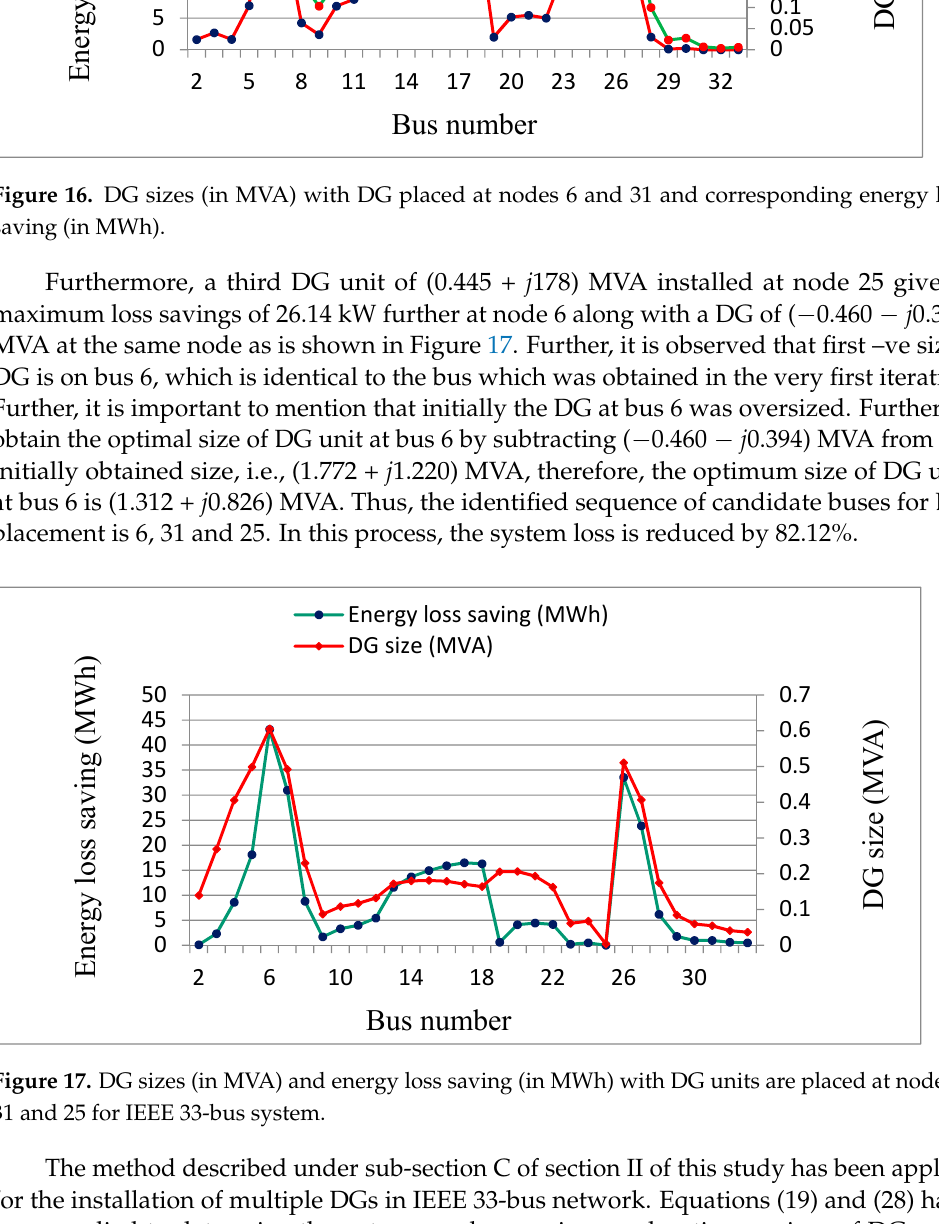
Figure 16. DG sizes (in MVA) with DG placed at nodes 6 and 31 and corresponding energy loss saving (in MWh).